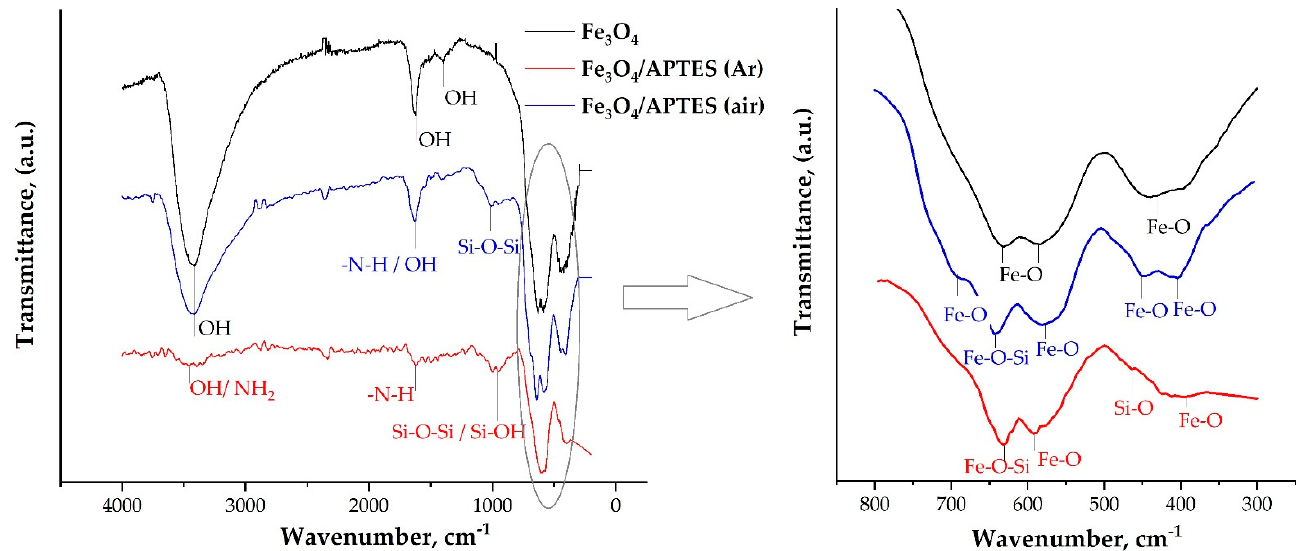
Figure 3. FTIR spectra of MNPs preparations.